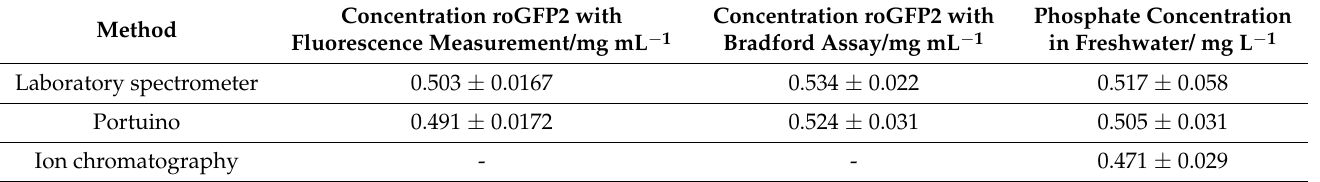
Table 1. Real sample analysis with the Portuino in comparison with a laboratory spectrometer. Redox- sensitive green fluorescent protein was measured either by fluorescence measurement or protein measurement, conducted according to Bradford method. Phosphate concentration in a freshwater sample was determined using a commercially available test